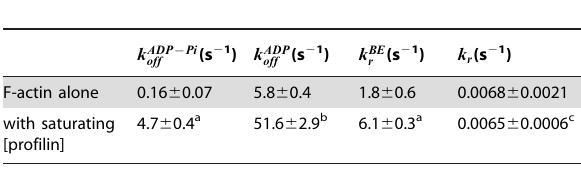
Table 1. Rate constants for the dissociation of actin monomers and inorganic phosphate (Pi) from filaments depolymerizing by their barbed